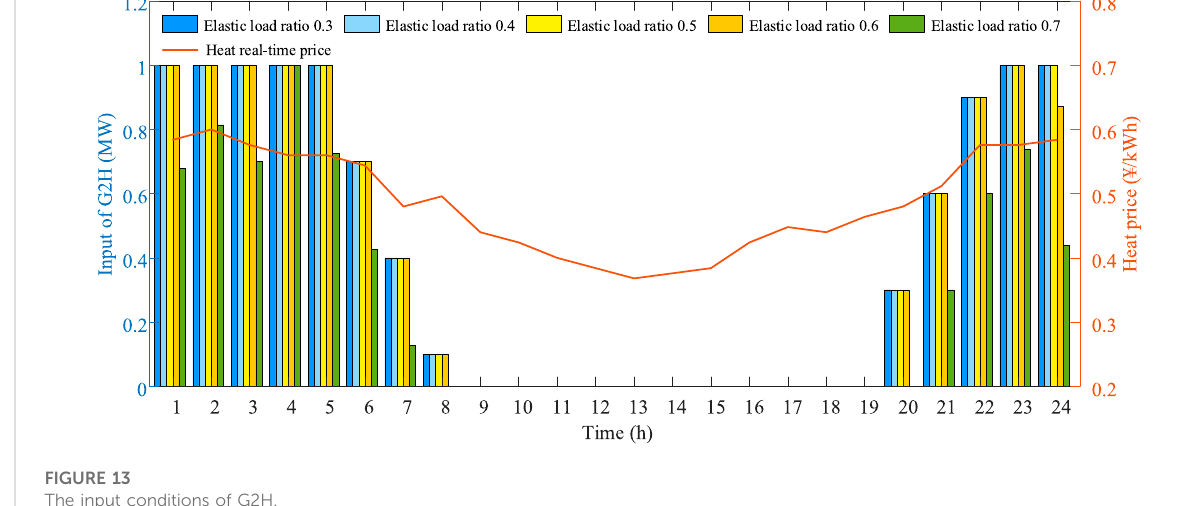
FIGURE 13 The input conditions of G2H.